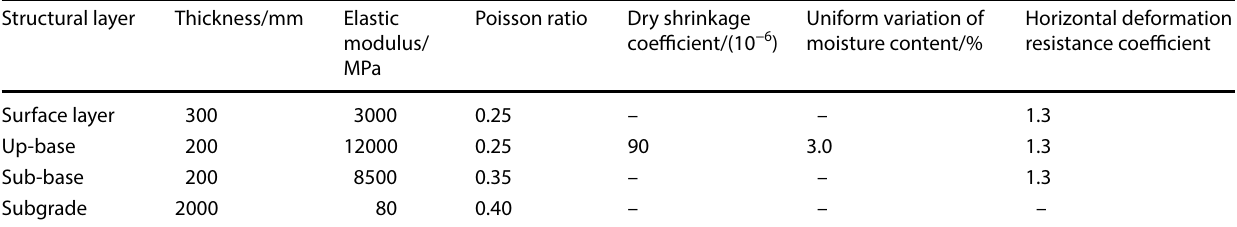
Table 1 Pavement structure layer correlation coefficients